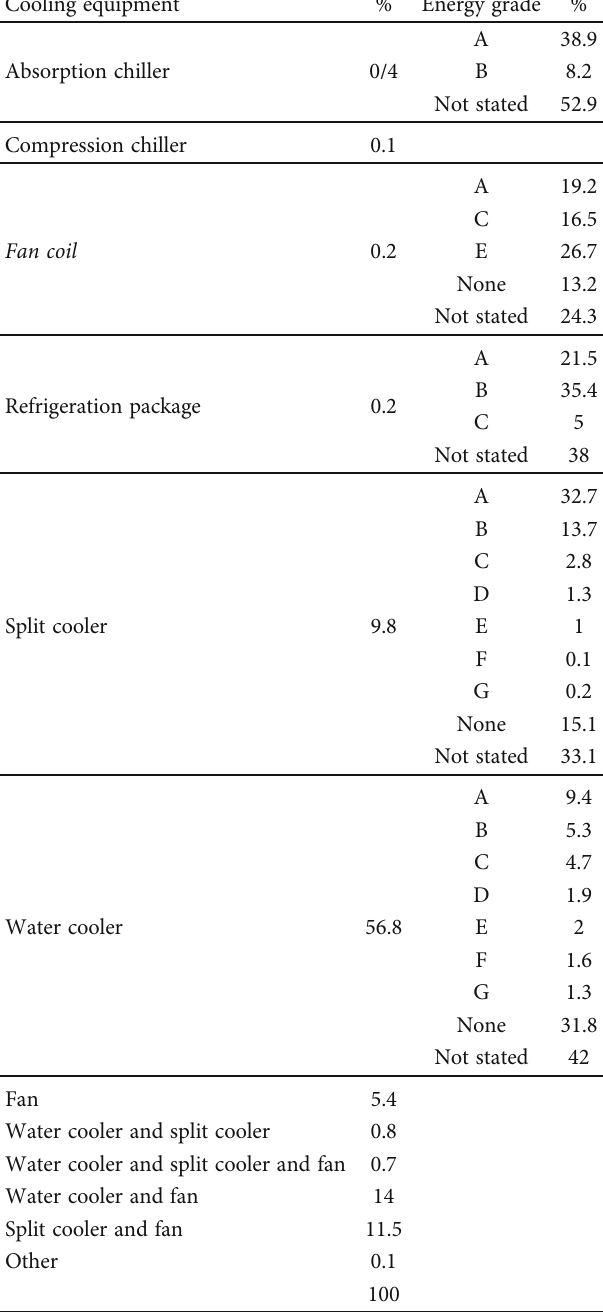
Table 10: Distribution of cooling equipment used in residential buildings —“ Results of Statistics on Energy Consumption and Environmental Characteristics of Urban Households in 2016 ” by the Statistics Center of Iran.